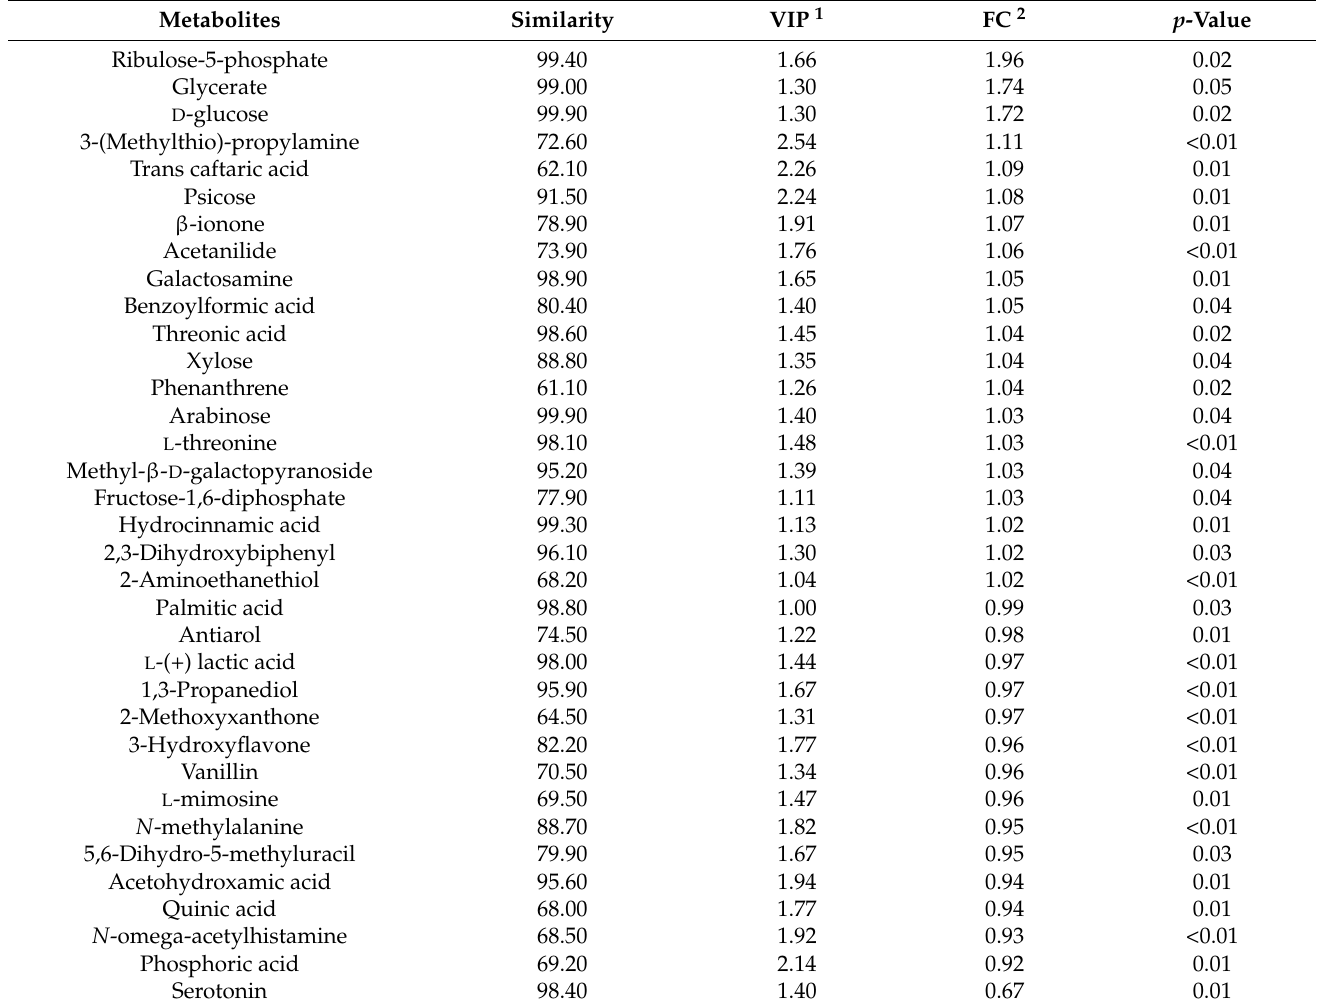
Table 5. Certification of significantly different metabolites in rumen fluid between the CON and DAN groups. Metabolites Similarity